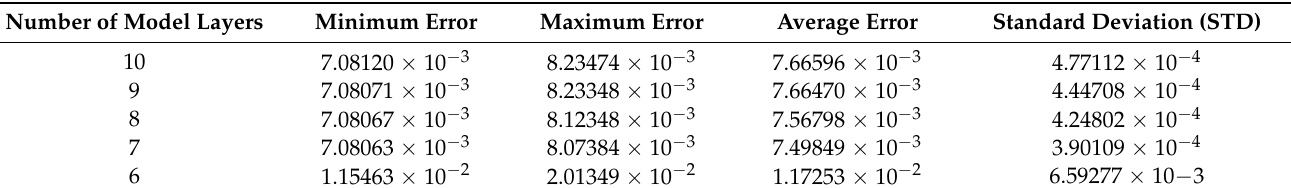
Table 9. Statistical analysis of the error for optimization of the initial drug concentration and diffusion coefficient (Case 2).